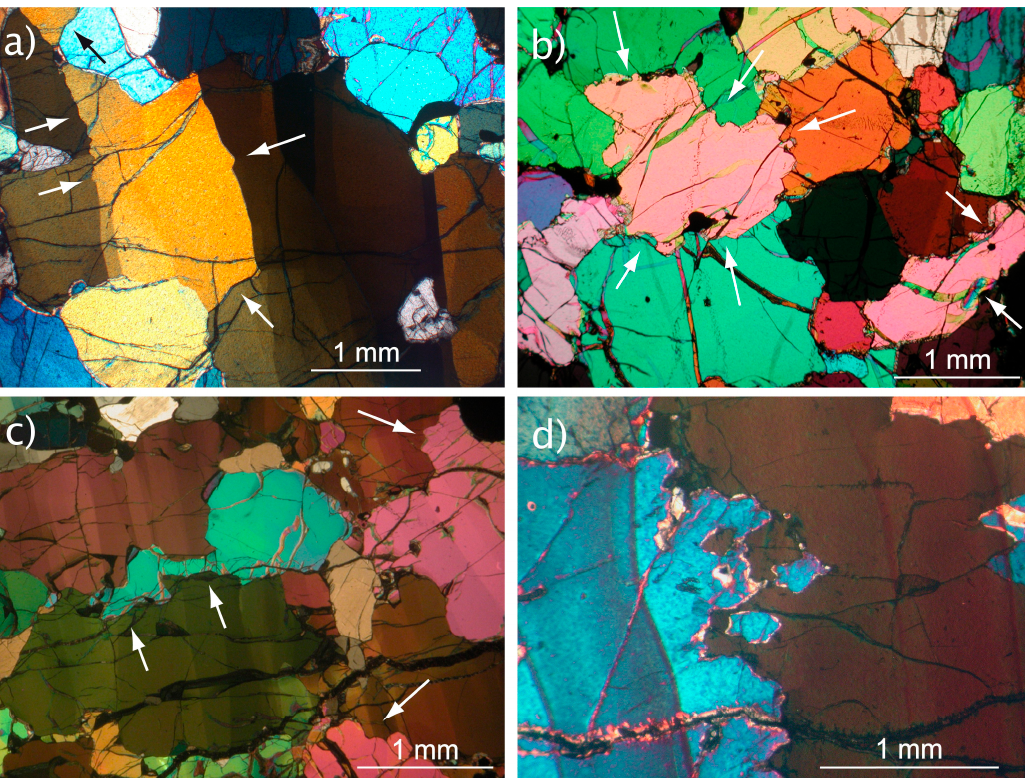
Figure 11. Evidence for GB and SGB migration and GB bulging in natural samples (arrows). ( a ) Olivine grains within a coarse porphyroclastic harzburgite (ET72, see [39]) shown with well- developed (100) SGB and very sinuous GB; courtesy A. Tommasi. ( b ) Olivine grains in a dunite from French Polynesia (RP6, see [38]); courtesy A. Tommasi. ( c ) Olivine grains in a harzburgite from French Polynesia (RPA18A, see [38]); courtesy A. Tommasi. ( d ) Evidence for GB bulging in olivine within a peridotite from a Labait volcano xenolith (Tanzania, [37]); courtesy A. Vauchez.